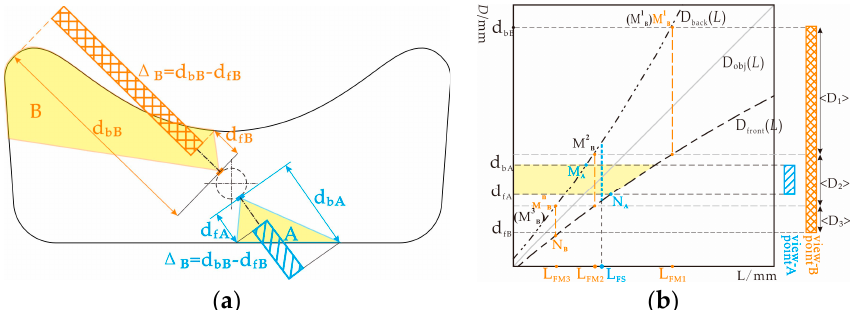
Figure 2. DoF principle of pinhole and cross-modal all-in-focus imaging strategy: ( a ) radial section diagram of the irregular pipe; ( b ) adaptive hybrid focusing principle.